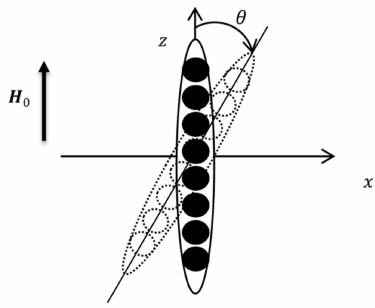
Figure 15. Illustration of modeling the chain-like aggregates as ellipsoids of revolution along the axis z. The chain parallel to the applied field corresponds to the non-deformed sample, and the declined chain to the sheared